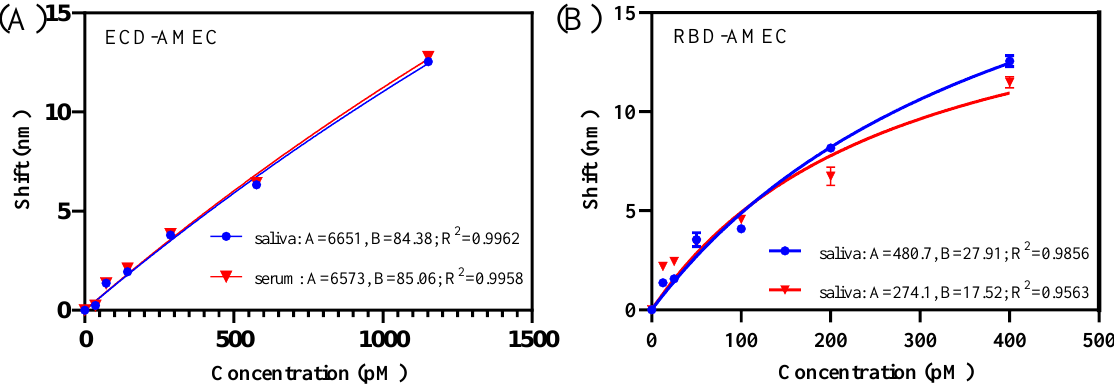
Figure 4. Performance of the AMEC-based FO-BLI biosensor for SARS-CoV-2 RBD and ECD detection in spiked saliva and serum. ( A ) Nonlinear binding curve of ECD detection (36–1152 pM) in high-salt diluted saliva (2-fold) and serum (2-fold); ( B ) Nonlinear binding curve of RBD detection (12.5–400 pM) in high-salt diluted saliva (2-fold) and serum (2-fold). Table 2. Comparison of performance of the optical biosensors reported in literature and this work for SARS-CoV-2 detection. Substrate Signal Transducer Automated Ref. [12] RBD